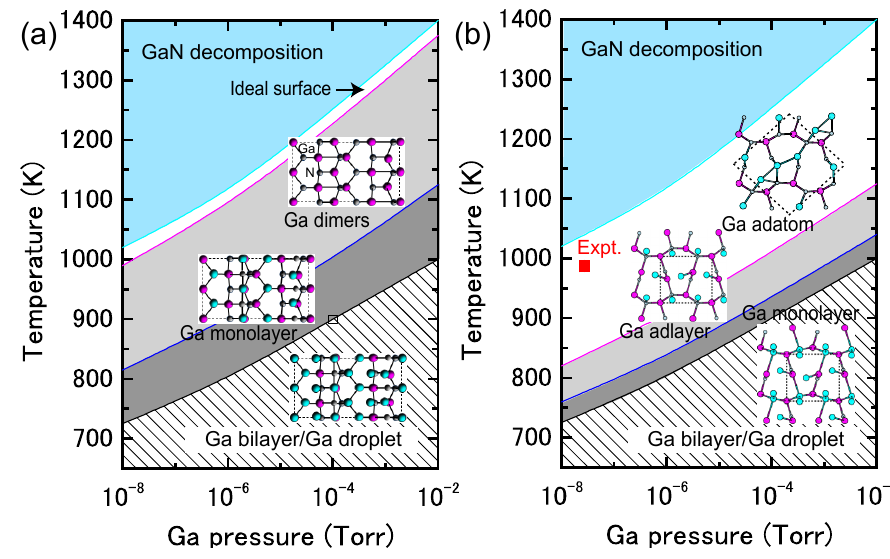
Figure 16. Calculated phase diagrams for nonpolar GaN surfaces with ( a ) (cid:4666)11(cid:3364)01(cid:4667) and ( b ) (cid:4666)112(cid:3364)2(cid:4667) orientations as a function of temperature and Ga BEP. The surface stable reconstructions are also schematically